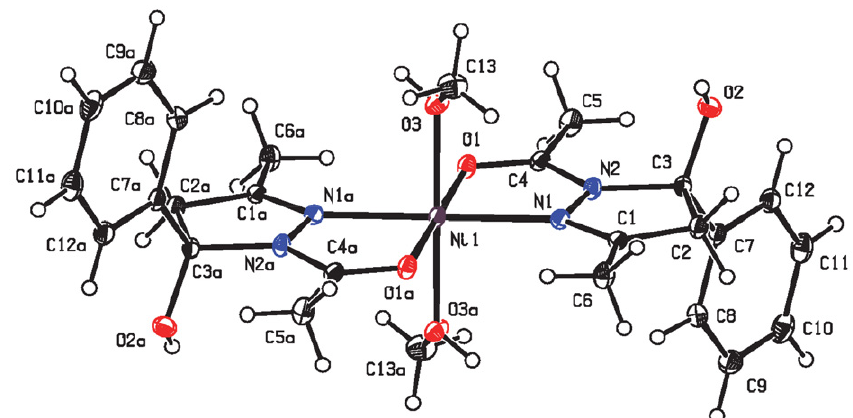
Fig. 1. The molecular structure of complex 1 with labelling of selected atoms, ellipsoids show 30% probability levels (symmetry code: (a) – x + 1, – y + 1, – z +